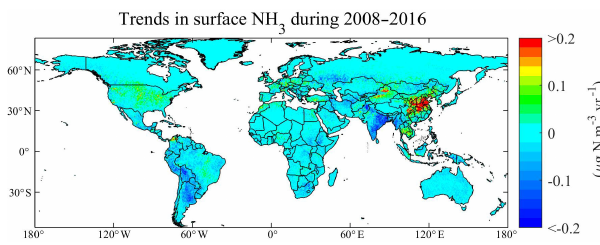
Figure 14. Gridded annual changes in surface NH 3 concentra- tions gained by IASI retrievals during 2008–2016 (Liu et al., 2019). We have released the global surface NH 3 concentrations dur- ing 2008–2016 at the website: https://zenodo.org/record/3546517# .Xj6I4GgzY2w, last access: 17 July